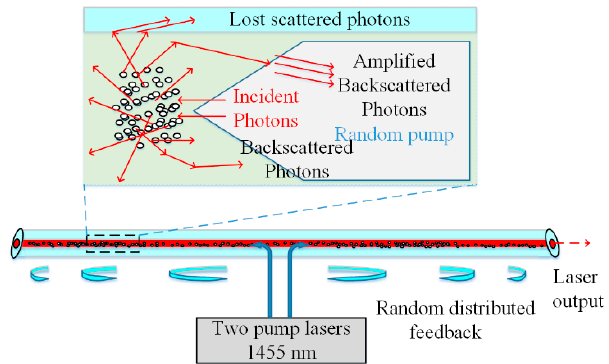
Figure 2. Principle scheme of random distributed feedback fiber laser operation.